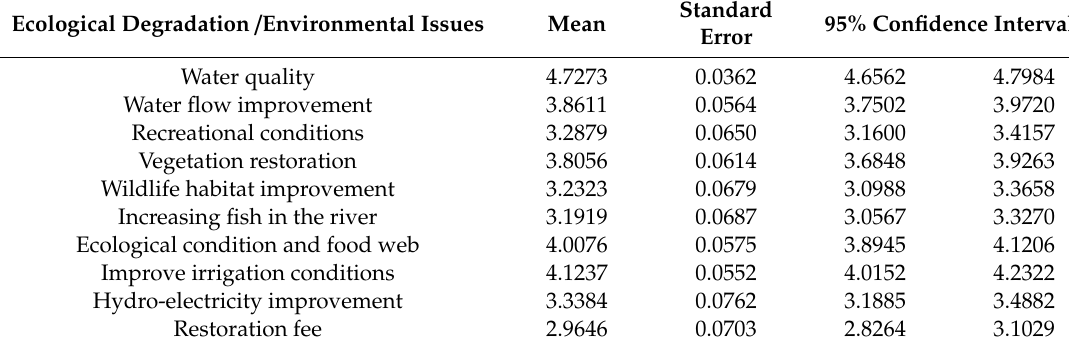
Table 5. Ranking of importance for various ecological restoration